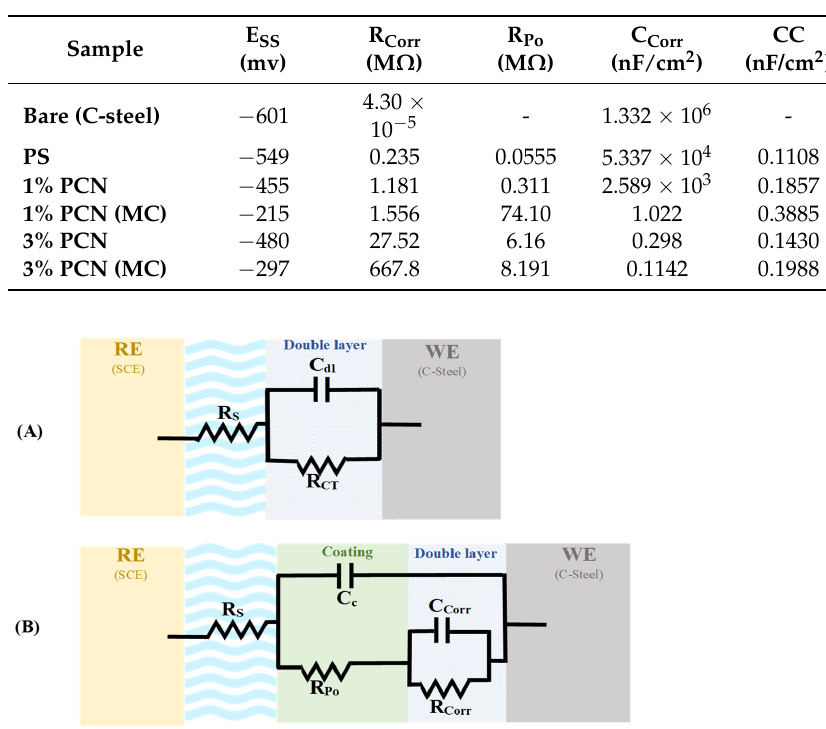
Table 3. The EIS fitted data of bare C-steel, PS, 1% PCN, 3% PCN, 1% PCN (MC) and 3% PCN (MC)